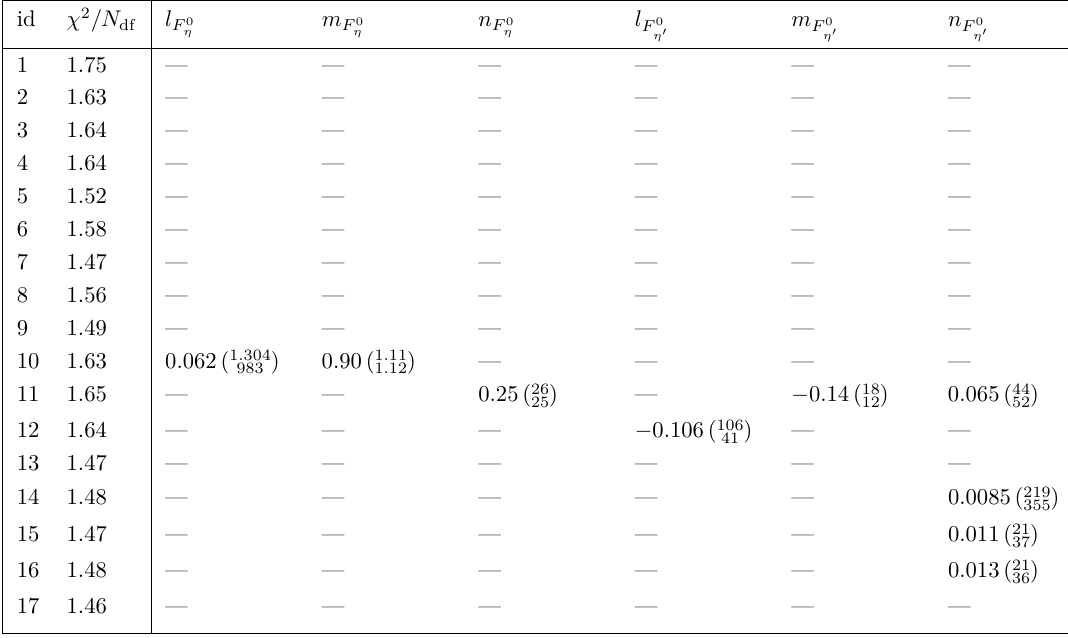
Table 23. Fit parameters, accompanying quadratic lattice effects for the singlet decay constants, see eq. (5.53). The fit ids are defined in table